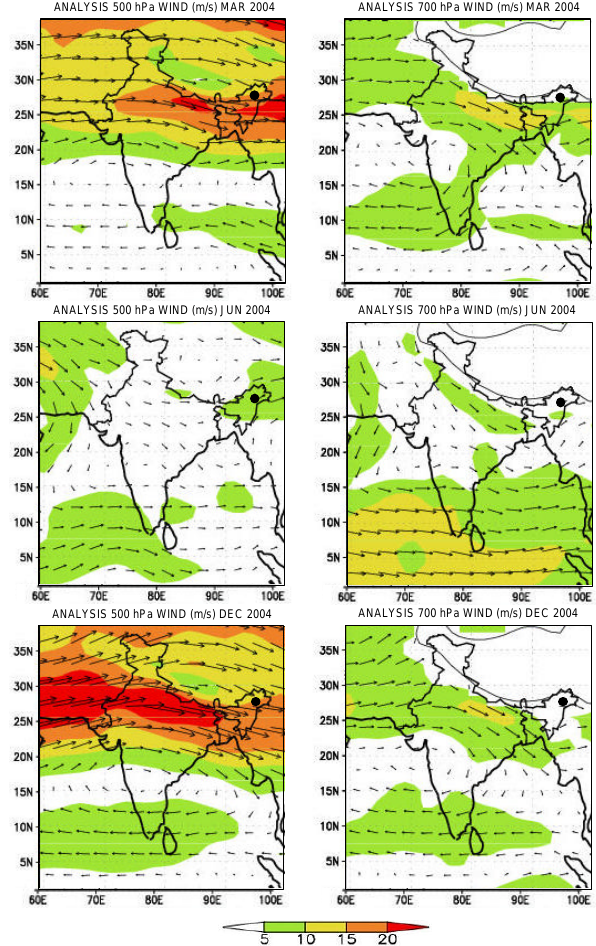
Figure 12 : Mean analysis wind pattern for the month of March, June and December at 700 Fig. 12. Mean analysis wind pattern for the month of March, June and December at 700hPa and 500hPa, as obtained from NCMRWF, hPa and 500 hPa as obtained from NCMRWF, New Delhi. The black circle in the figure New represents the position of Dibrugarh.